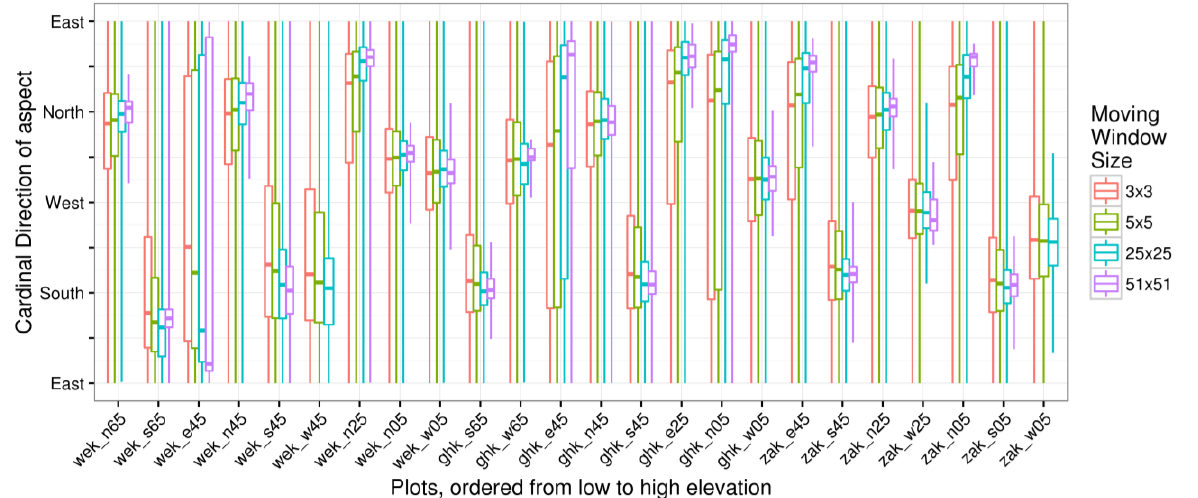
Figure 11. Distributions of cell aspects for each plot by moving window sizes. Vertical lines represent the range of absolute values, horizontal lines are the median values and the box margins are the 25 th and 75 th quantile. Plot names are abreviations for the summits, the cardinal directions and altitudes below the